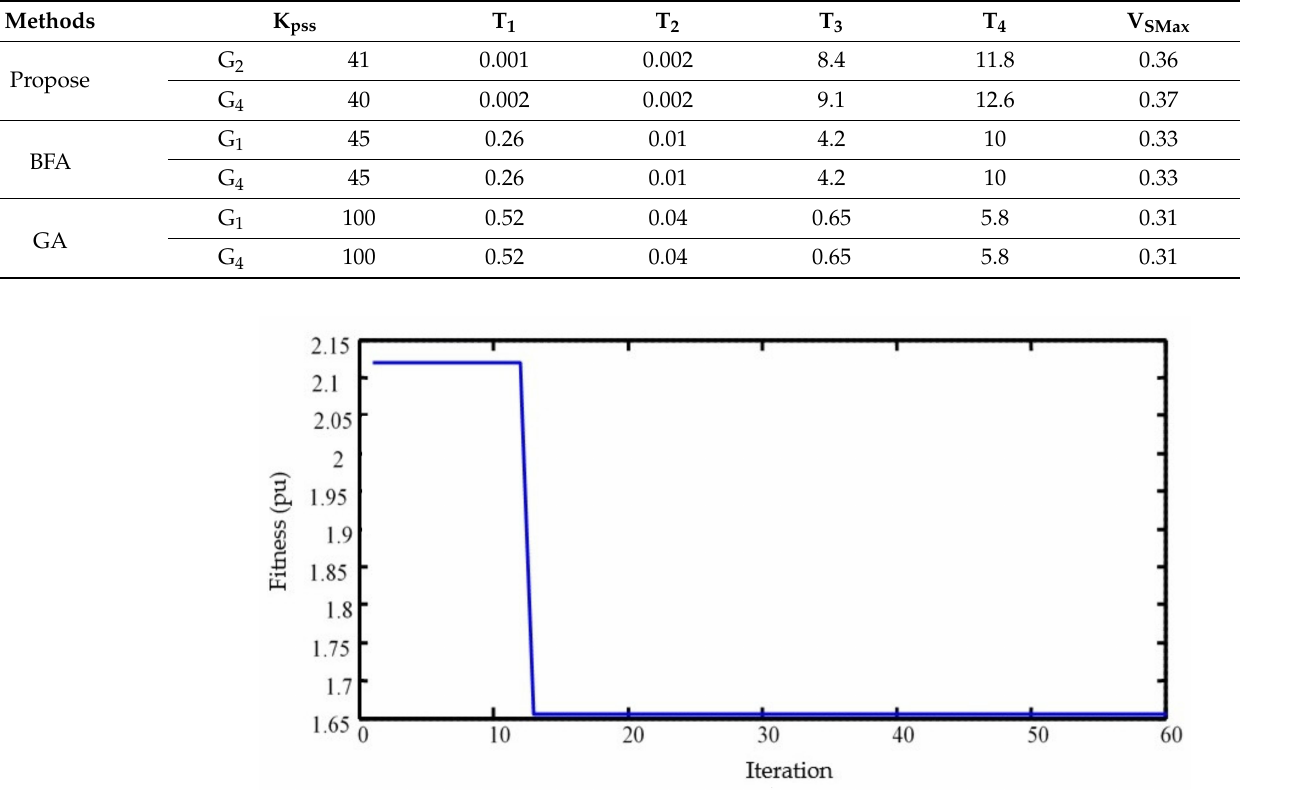
Figure 10. Convergence changes of the PSO in locating the PSS of the four-machine power system in the second scenario.